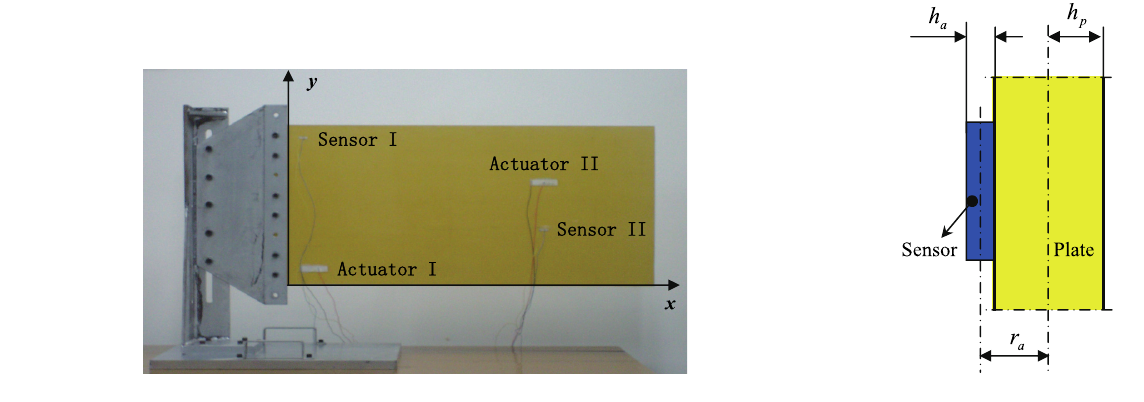
Fig. 2. Photo of experiment plate. Fig. 3. Sketch map of r a